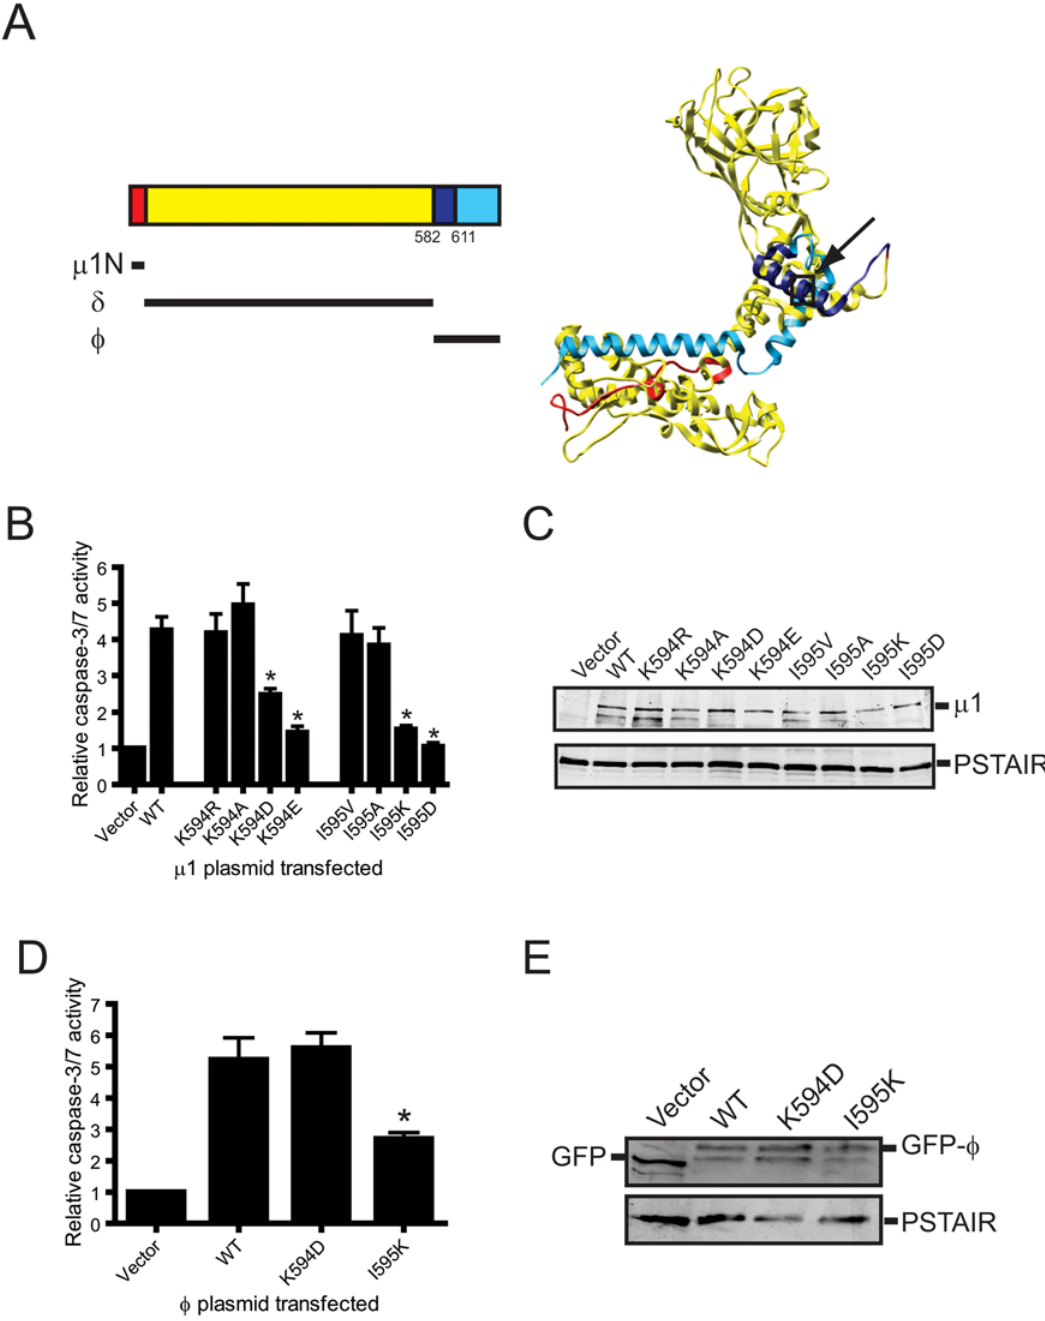
Figure 1. Charge substitutions of m 1 Q residues Lys594 and Ile595 diminish apoptosis-inducing capacity of ectopically expressed m 1 and Q . (A) Crystal structure of a m 1 monomer (PBD:1JMU) [36]. The m 1N, d , and Q domains are indicated in red, yellow, and blue, respectively. The location of a minimal functional region of Q (spanning amino acids 582–611) sufficient for apoptosis induction following expression in cells [33] is indicated in dark blue. A black box indicates the position of Lys594 and Ile595. (B) 293T cells were transfected with a plasmid expressing either wild- type or the indicated point-mutant m 1 protein. Caspase-3/7 activity in cell lysates was quantified 24 h post-transfection. Results are expressed as the mean ratio of caspase-3/7 activity from transfected cell lysates to that from empty vector-transfected cells for triplicate samples. Error bars indicate SD. *, P , 0.05 as determined by Student’s t -test in comparison to cells infected with wild-type m 1. (C) 293T cells treated with Z-VAD-FMK were transfected with a plasmid expressing either wild-type or the indicated point-mutant m 1 protein. Cell lysates were prepared at 24 h post-transfection, resolved by SDS-PAGE, and immunoblotted using a MAb specific for m 1 (upper panel). As a control for protein concentration, the blots also were probed with an antibody specific for the PSTAIR peptide of Cdk1 (lower panel). (D) 293T cells were transfected with a plasmid expressing either wild- type, K594D, or I595K GFP-tagged Q protein. Caspase-3/7 activity in cell lysates was quantified 24 h post-transfection. Results are expressed as the mean ratio of caspase-3/7 activity from transfected cell lysates to that from empty vector-transfected cells for triplicate samples. Error bars indicate SD. *, P , 0.05 as determined by Student’s t -test in comparison to cells infected with wild-type m 1. (E) 293T cells treated with Z-VAD-FMK were transfected with a plasmid expressing either wild-type, K594D, or I595K GFP-tagged Q protein. Cell lysates were prepared at 24 h post-transfection, resolved by SDS-PAGE, and immunoblotted using a MAb specific for GFP (upper panel). As a control for protein concentration, the blots also were probed with an antibody specific for the Cdk1 PSTAIR peptide (lower panel).